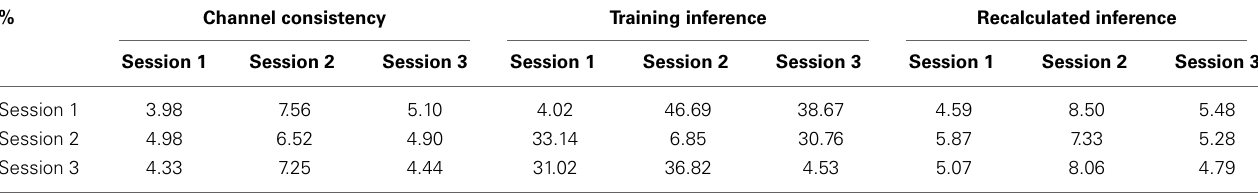
Table 2 | Mean values of the error matrices whose element is the BCG estimation error ( ave nRMSE ) in percentage (%) for a model whose subset of channels and inference matrix were learned from one training segment and applied to another testing segment.